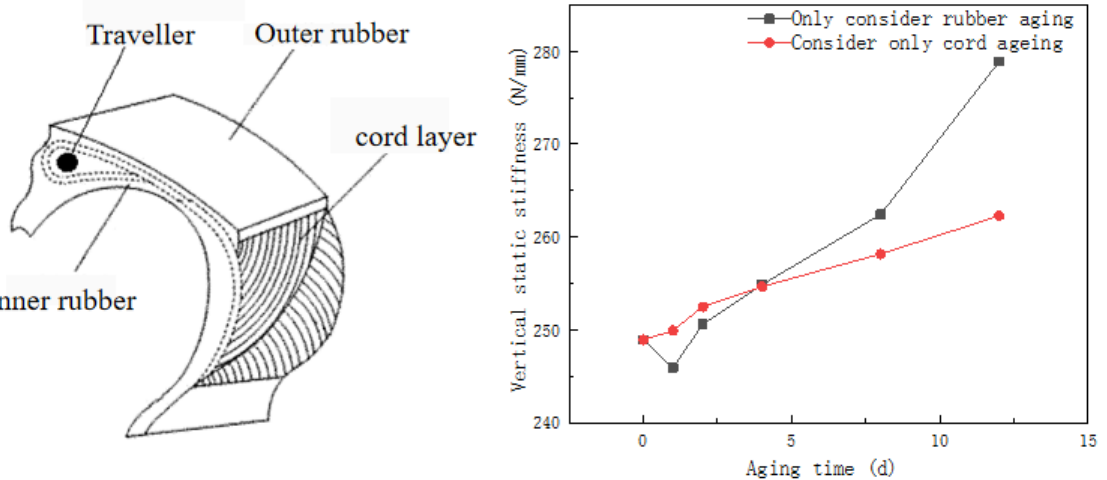
Figure 6. Consider the vertical static stiffness of an air spring affected by rubber aging and cord aging